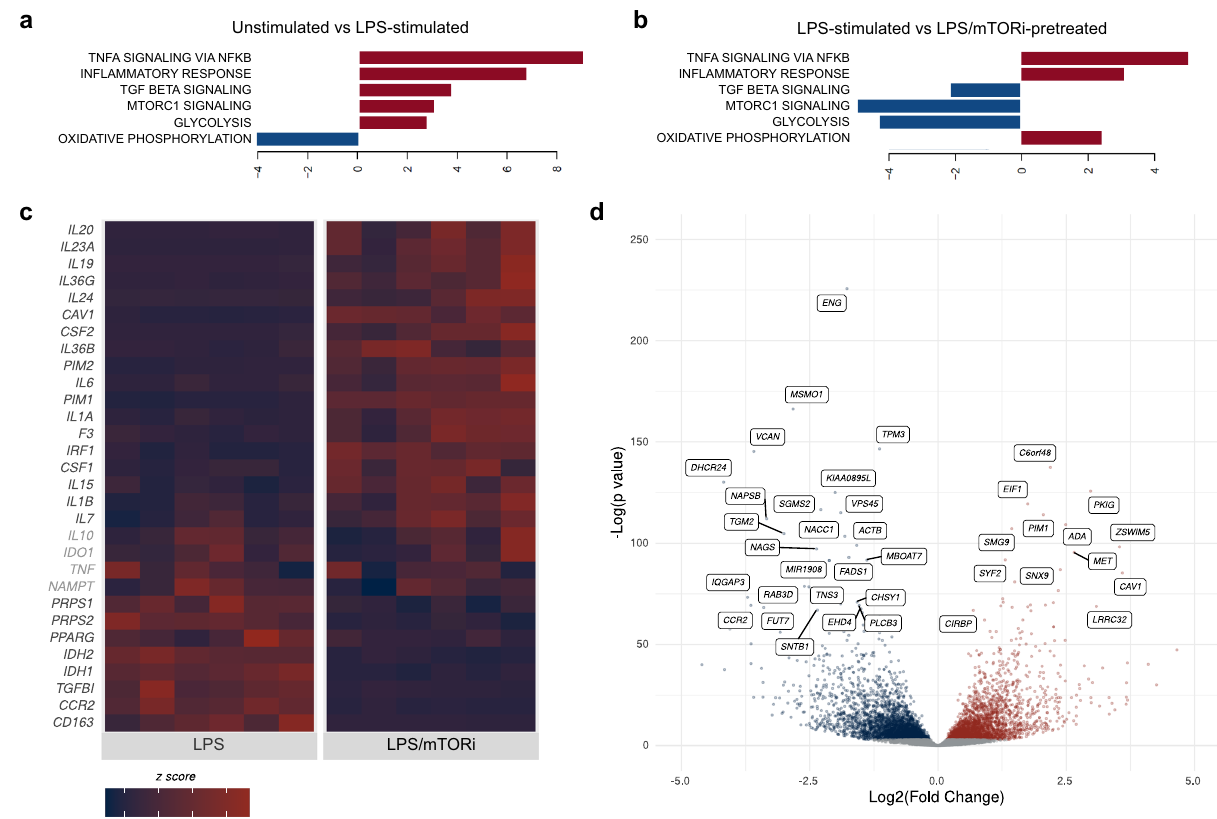
Fig. 3 mTOR inhibition of LPS-stimulated monocytes promotes an in fl ammatory transcriptional program. a – d Monocytes from six independent donors were pretreated with an mTORi (AZD2014 at 5 μ M, 6 h) or DMSO and stimulated with LPS (1 ng, 6 h) for bulk RNA-seq analysis. Select HALLMARK gene sets identi fi ed as differentially regulated through GSEA, presenting expression data comparing LPS-stimulated monocytes to unstimulated monocytes ( a ) and mTORi-treated, stimulated monocytes to LPS-stimulated monocytes without mTORi pretreatment ( b ) 81 . For complete HALLMARK GSEA, see also Supplementary Fig. 4. c , d Differential expression of genes of interest. c Expression normalized by z score; genes that did not reach signi fi cance are noted in light gray. d Signi fi cantly upregulated (red) or downregulated (blue) genes determined using an FDR adjusted p value cut-off of 0.05. Top 50 genes by FDR adjusted p value